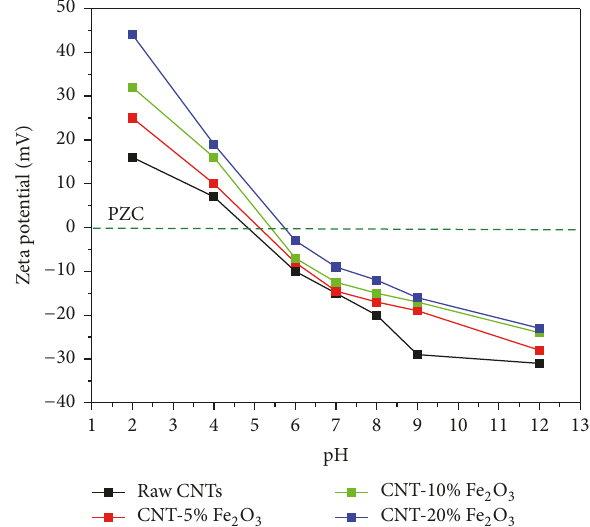
Figure 4: TGA analysis of raw CNTs and CNT-5% iron oxide, CNT- 10% iron oxide, and CNT-20% iron oxide.